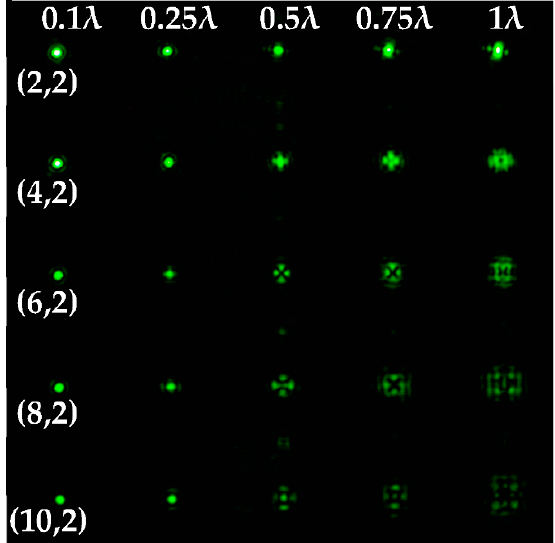
Figure 6. The experimentally registered intensity distribution for the Gaussian beam illumination of the multi-channel DOE matched with different astigmatic aberrations of type ( n , 2) of different levels of α from 0.1 λ to λ . Table 8. The experimental results for the 25-channel DOE when illuminated with a vortex beam with TC l = 1, 2, 3, 5 (diffractive orders with astigmatic intensity pictures convenient for TC recog- nition were marked with frames).